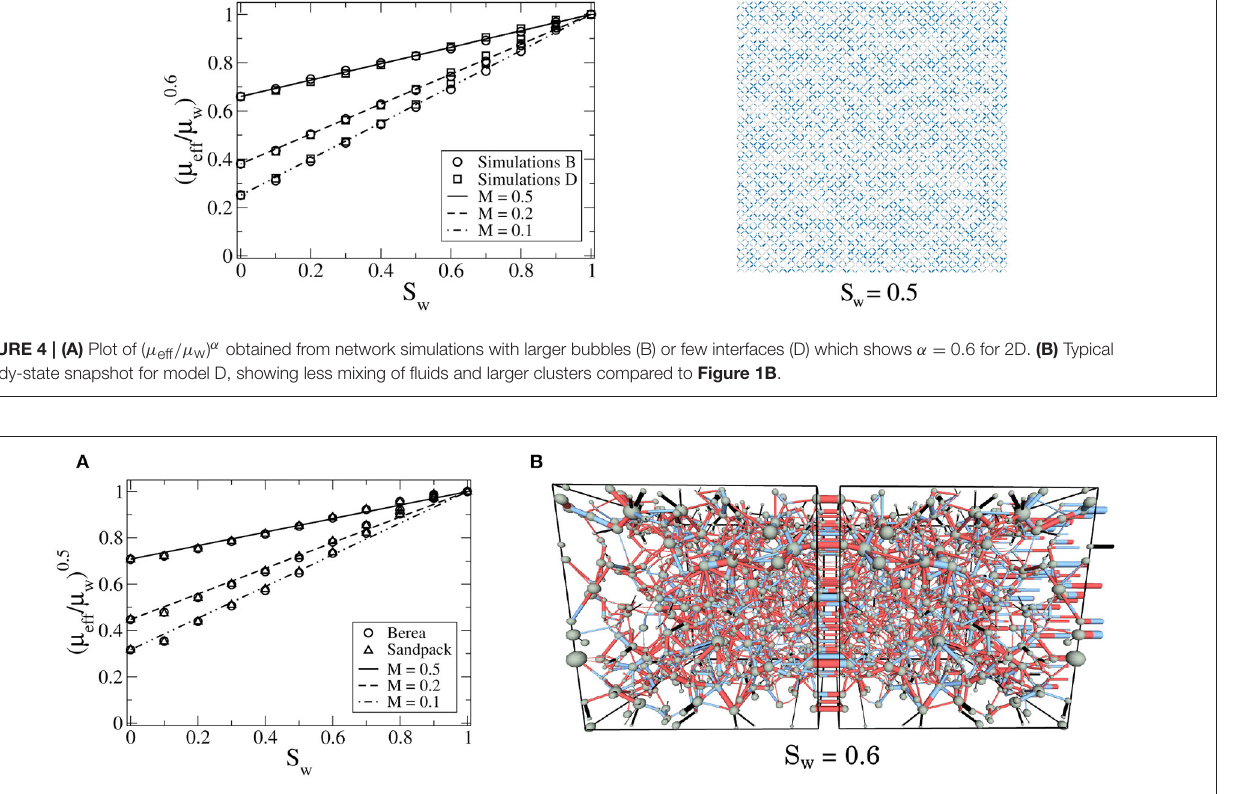
FIGURE 5 | (A) Plot of ( µ eff /µ w ) α for 3D networks reconstructed from Berea sandstone and sandpack samples for the simulations with two interfaces (D). Results are consistent with Equation (14) (straight lines) with α 0.5. A steady-state snapshot of Berea sandstone for model D is shown in (B) , where blue and red are the wetting = and non-wetting fluids respectively.